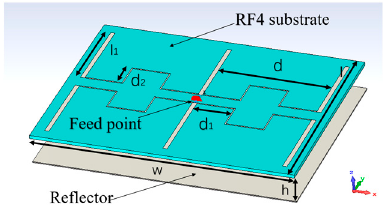
Figure 1. Geometry model of the printed dipole array antenna.